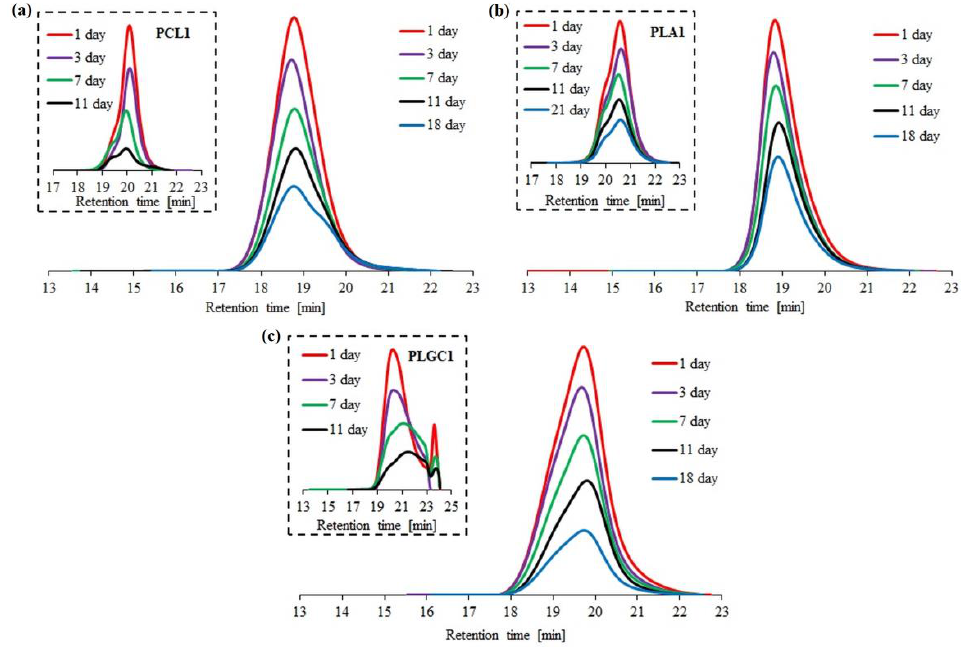
Figure 4. SEC traces obtained for enzymatic degradation of copolymer 2PCL2- b -PDMAEMA ( a ), copolymer PLA2- b -PDMAEMA ( b ) and copolymer PLGC2- b -PDMAEMA ( c ). SEC traces for the corresponding aliphatic polyesters are placed in brackets.